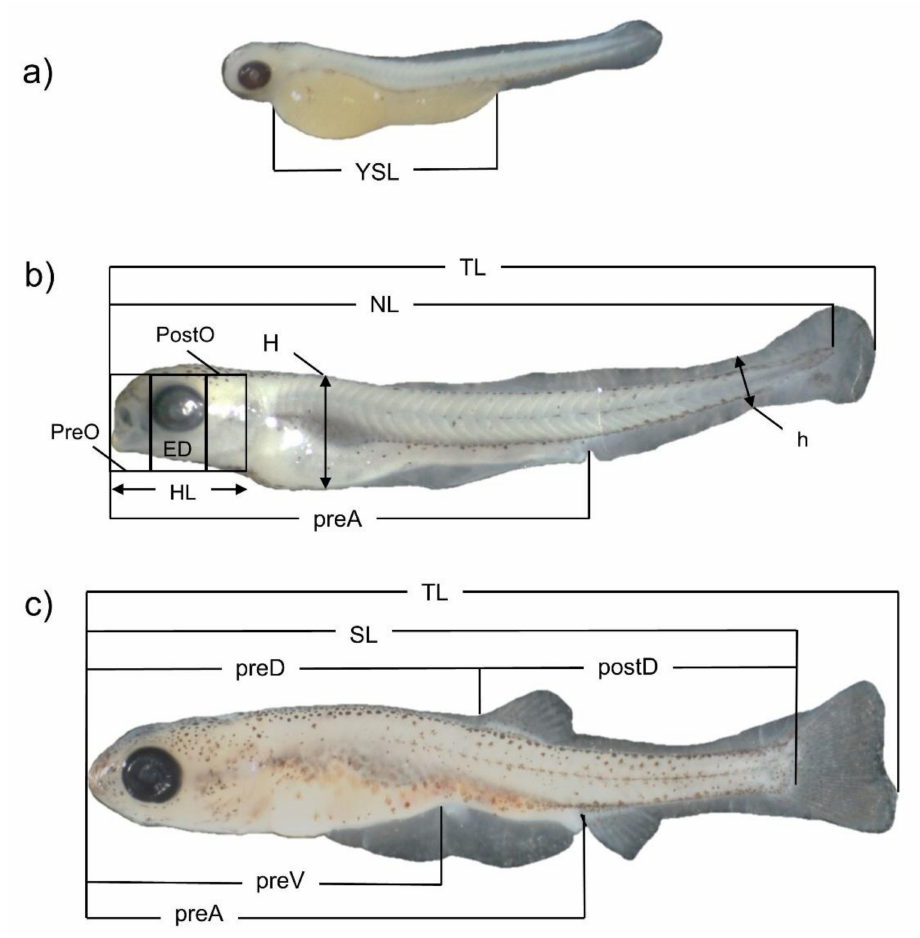
Figure 1. Fourtheen morphometric measures taken for Delminichthys krbavensis : total length (TL), notochordal length (NL), standard length (SL), predorsal length (PreD), postdorsal length (PostD), snout length (PreO), eye diameter (ED), postorbital space (PostO), head length (HL), preventral length (PreV), pre-anal length (PreA), maximum body depth (H), depth of caudal peduncle (h), length of yolk sack (YSL). Distinct lower case letters denote different stages of development: ( a ) day 4 PH, ( b ) day 11 PH and ( c ) day 48